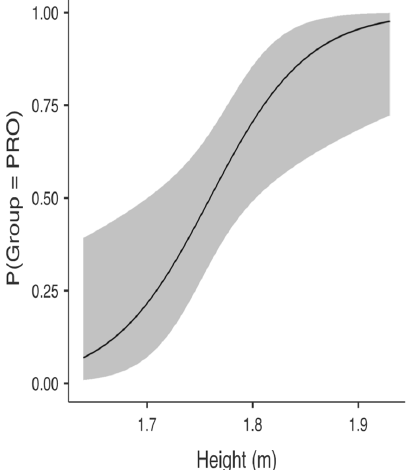
Figure 1. U19 body height probability to become professionals (PRO).